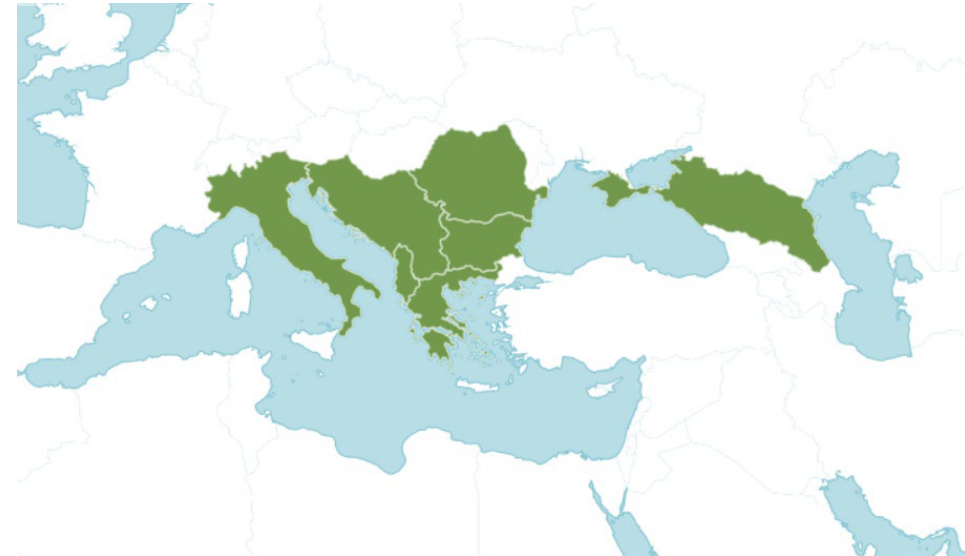
Figure 1. Distribution of Barrelier’s Speedwell. Source: https://powo.science.kew.org/taxon/urn:lsid:ipni.org:names:811672-1 (accessed on 10 August 2022).